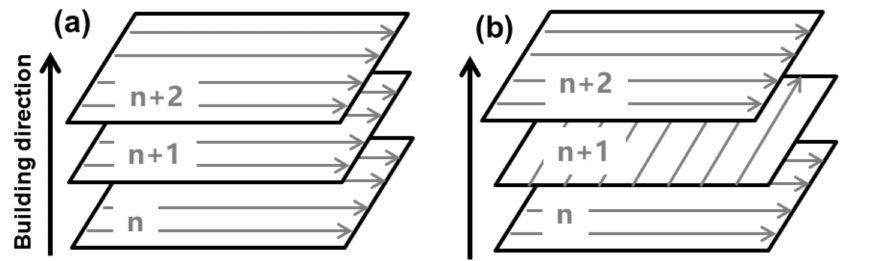
Figure 1. Schematic diagrams showing two different scanning strategies used in the present work: ( a ) single-directional scanning (SDS) and ( b ) cross-directional scanning (CDS). The metallographic samples were mechanically polished and then chemically etched with a solution of 100 mL H 2 O 2 , 100 mL HCl and 100 mL H 2 O for both optical micrograph (OM) observation and scanning electron microscopy (SEM) observation. Samples were also electrolytically polished with 10 vol% perchlorate alcohol solution at 20 V for 30 s for electron back scatter diffraction (EBSD) tests at an accelerating voltage of 20 kV and a step size of 1 µ